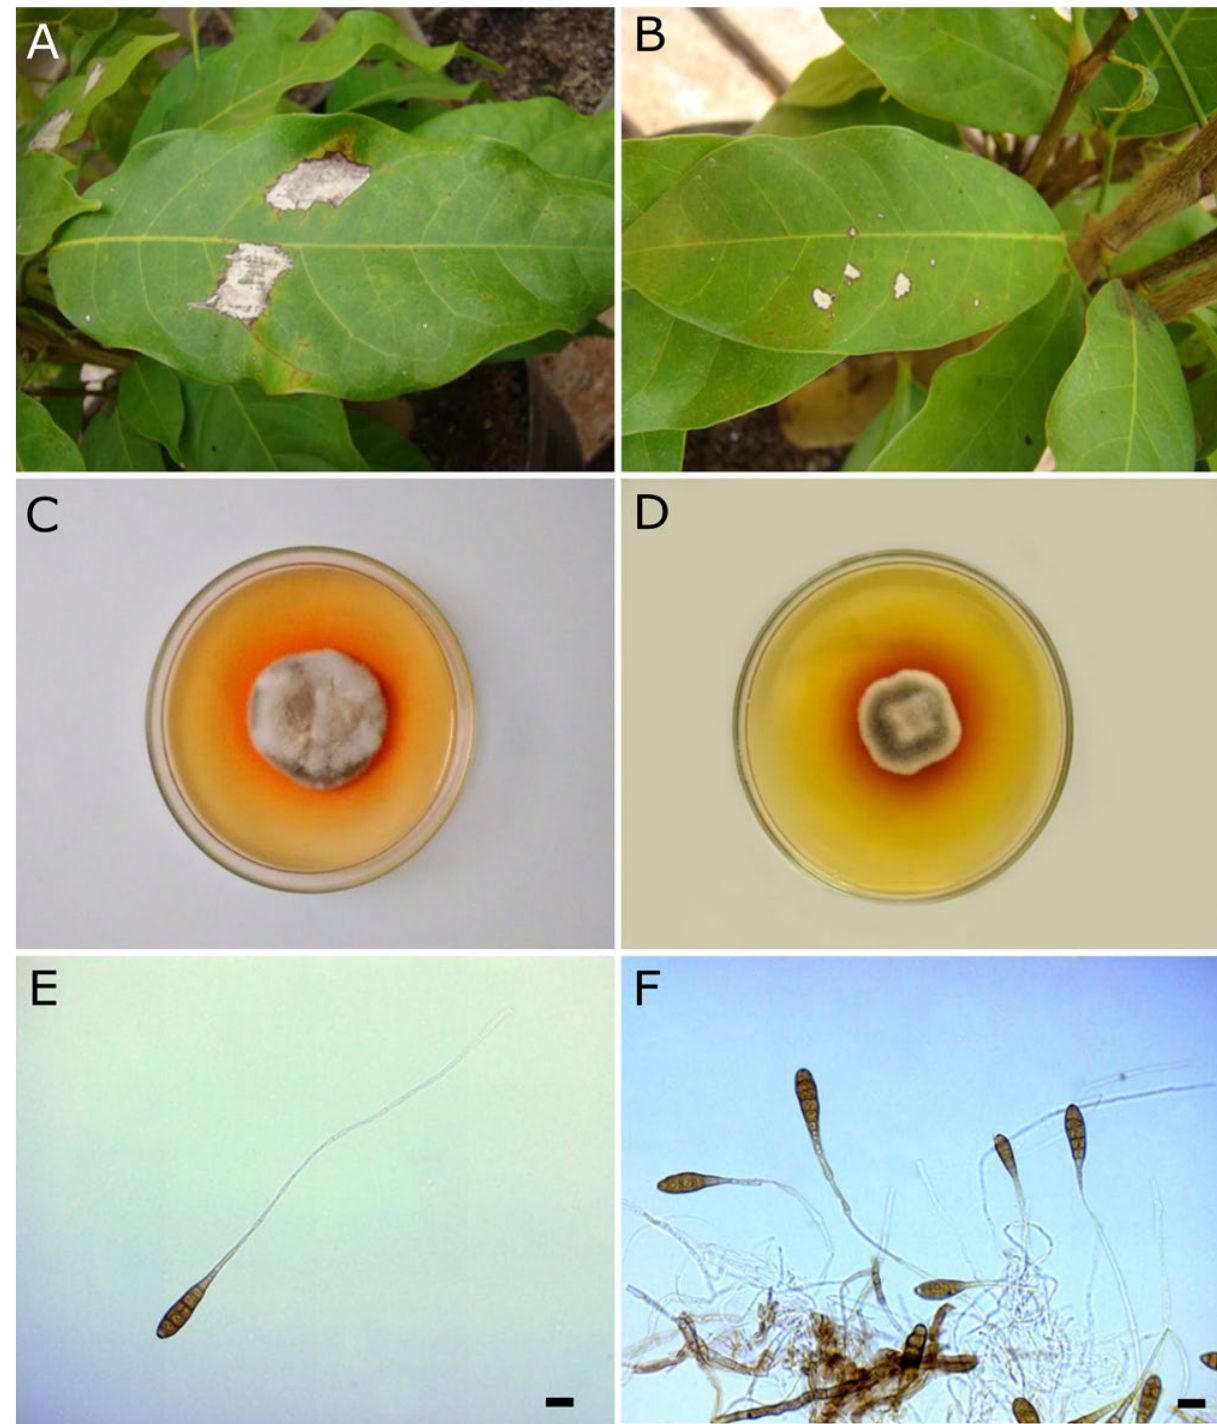
Figure 2. Symptoms of leaf spot caused by Alternaria argyroxiphii on Khaya senegalensis, and colony morphology and conidia of the pathogen. (A) Lesions on wounded and (B) unwounded inoculated leaves; (C) colony on PCA and (D) colony on PDA; (E and F) conidia. Scale bars = 10